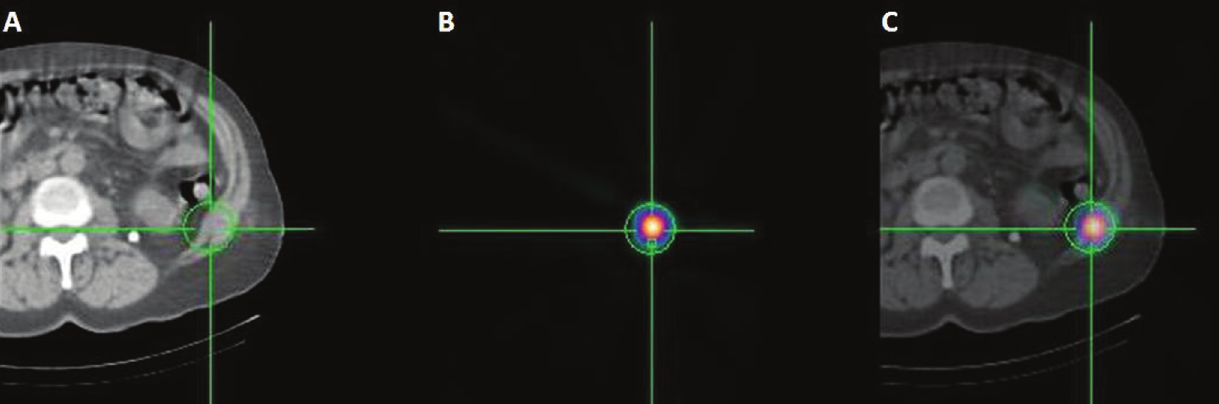
Figure 3 - SPECT-CT performed after Sn- 99m Tc injection into the lesion of the abdominal wall, left side. A) Anatomical image. B) Metabolic image. C) Fusion of the two